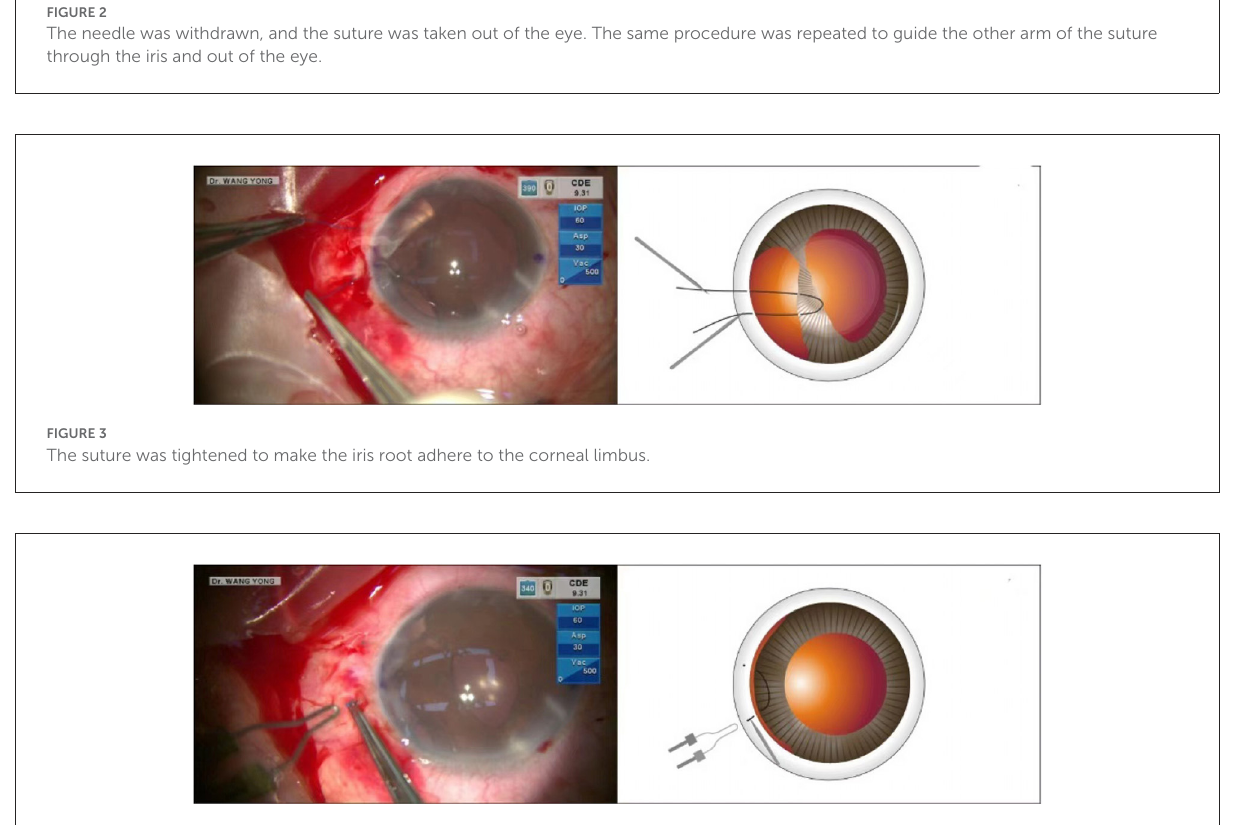
FIGURE4 After cutting the suture, it was cauterized into a flange and inserted in the sclera for fixation.